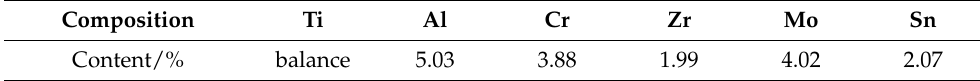
Table 1. The compositions of Ti17 alloy (wt.%).